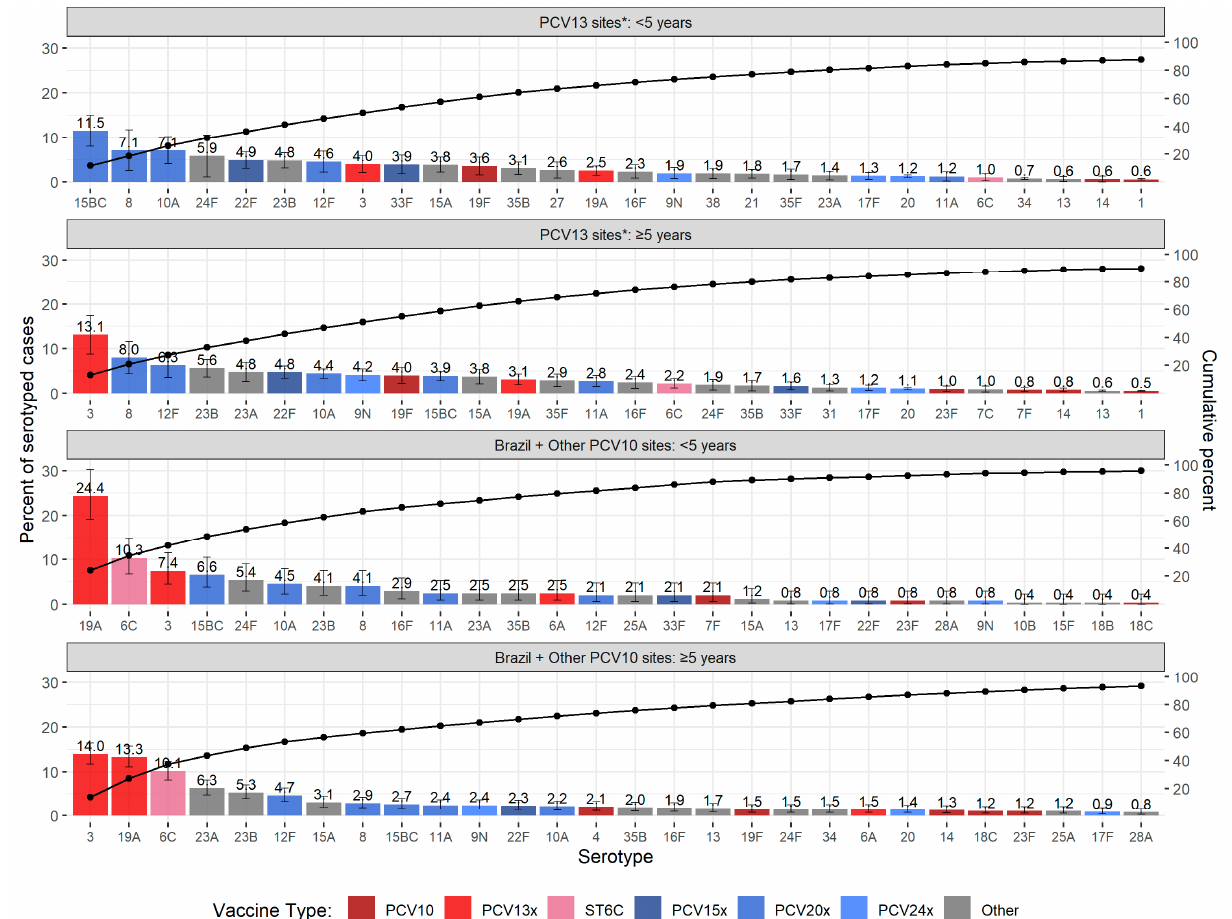
Figure 4. Serotype-specific distribution of CSF+ pneumococcal meningitis in the mature PCV10/13 period. Serotypes are colored by the lowest valency PCV product they are included in. The “x” in the PCV legend represents the extra serotypes included in that product relative to the next lower product (i.e., PCV13x includes serotypes 3, 6A, and 19A not in PCV10). PCV13 is Pfizer’s Prevnar13/Prevenar13; PCV10 is GSK’s Synflorix. Serotype 6C is colored separately because, although it is not included in any product, it is covered through cross-protection with PCV13-type serotype 6A [24]. Morocco and Bulgaria were not included in the PCV10 distribution due to serotyping limitations. * Serotype distribution for PCV13 sites is modeled output for the top 25 serotypes based on a pooled ranking plus serotype 1. Serotype distribution for PCV10 sites is from pooling cases across sites.